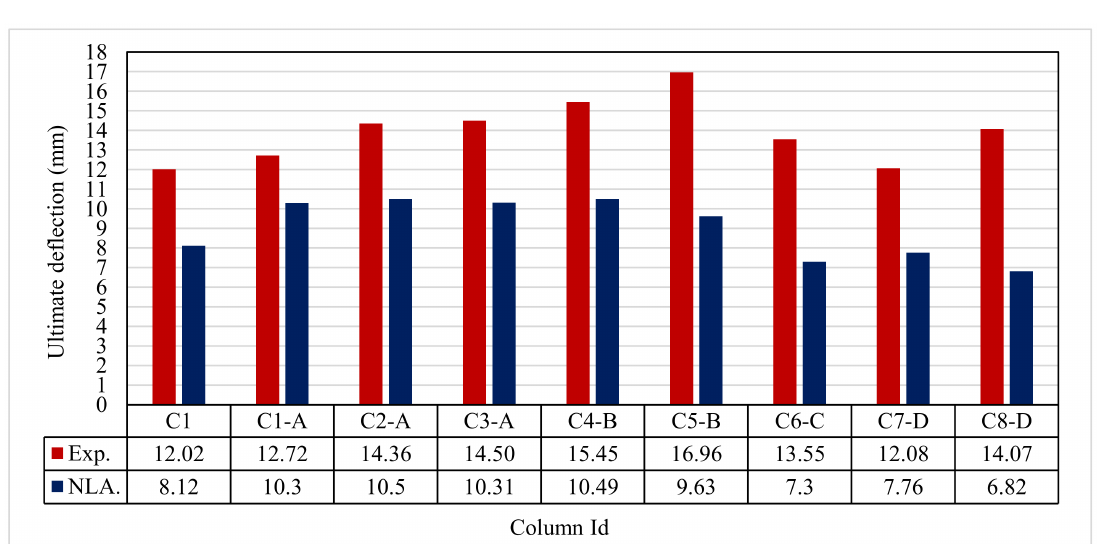
Figure 20. Comparison between Exp. and NLA ultimate